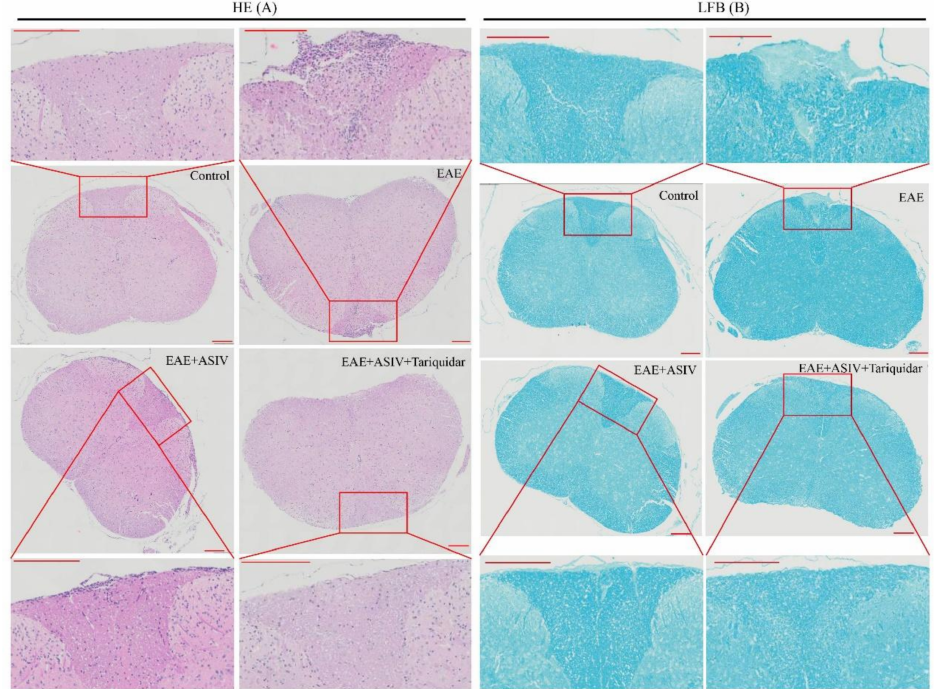
Figure 6. Tariquidar enhances the alleviative effect of ASIV on the inflammatory cell infiltration and demyelination of spinal cord in EAE mice. ( A ) Effect of coadministration of ASIV and tariquiar on the inflammatory cell infiltration. The spinal cord sections were stained by hematoxylin and eosin (H&E) staining method. ( B ) effect of coadministration of ASIV and tariquiar on the demyelination. The spinal cord sections were stained by luxol fast blue (LFB) staining method. Scale bar: 200 µ